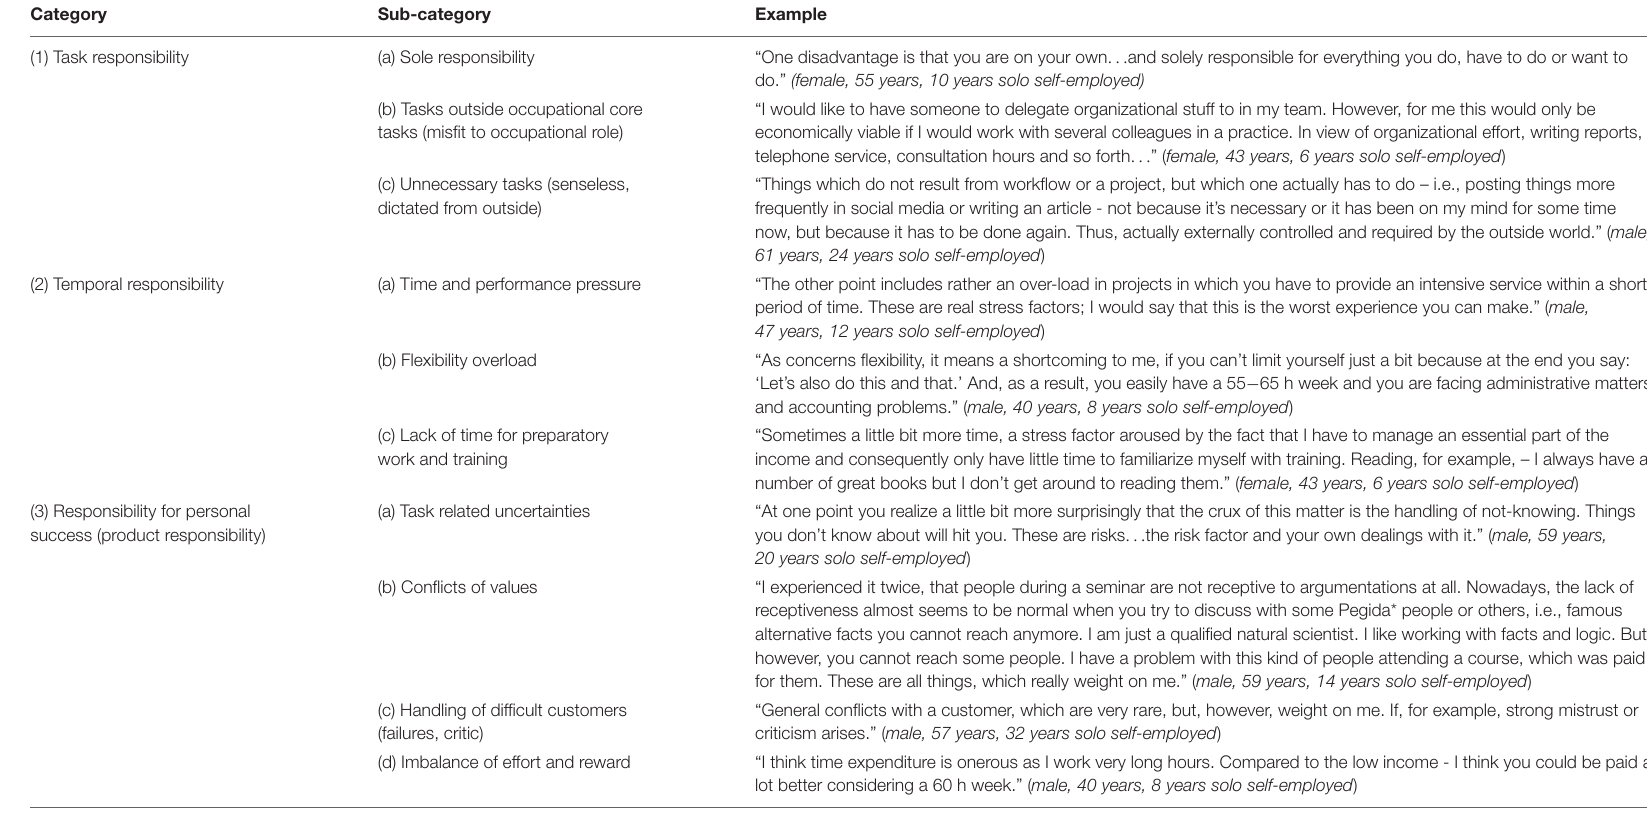
TABLE 2 | Demands arising from solo